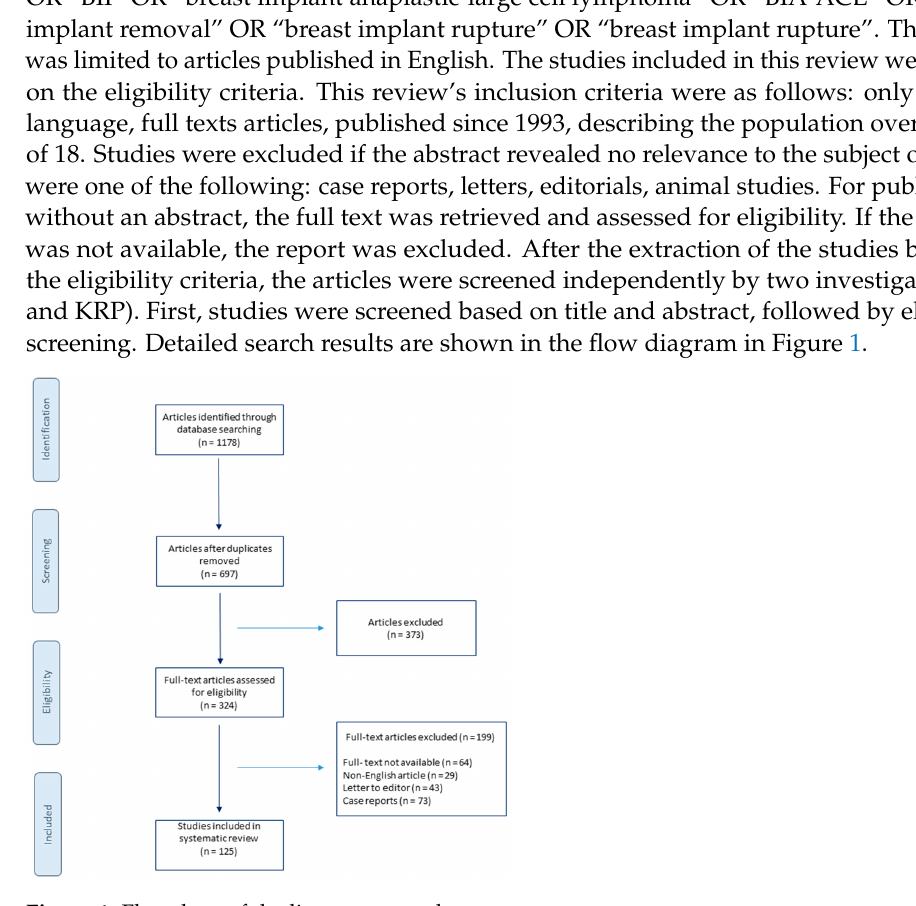
Figure 1. Flowchart of the literature